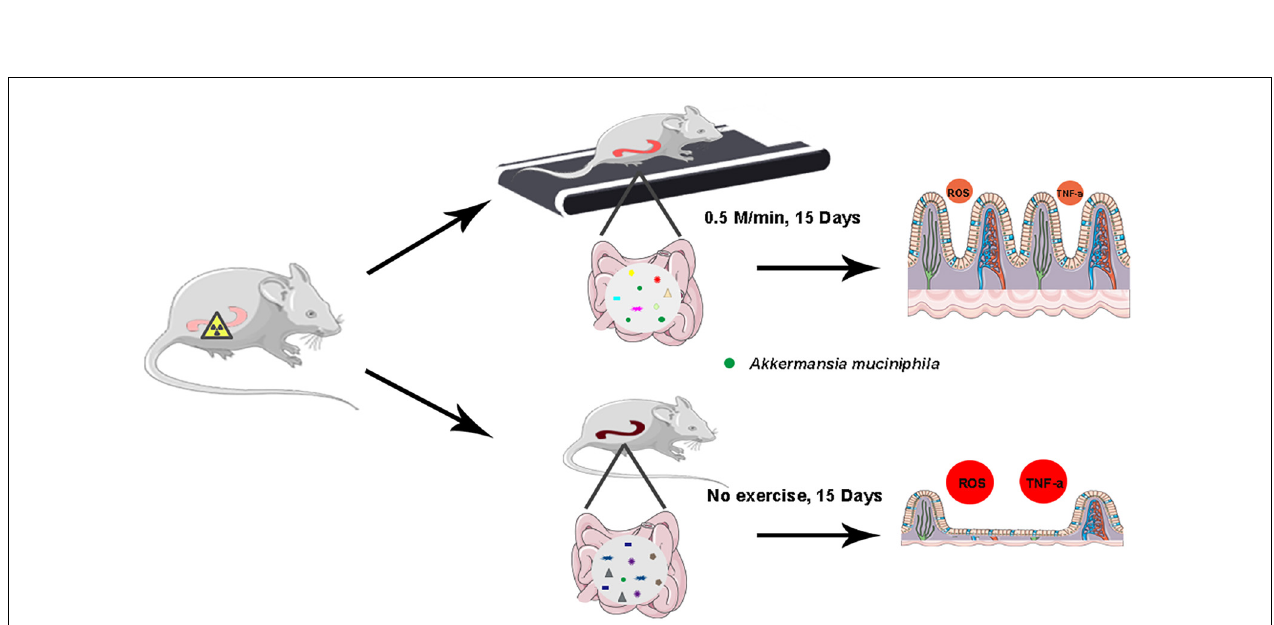
FIGURE 7 | Illustration of walking for the alleviation of radiation-induced intestinal inflammation.